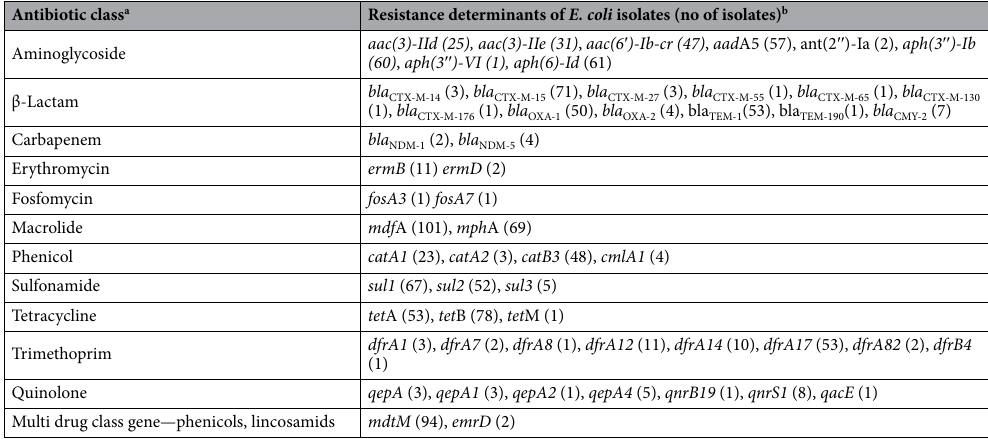
Table 2. Acquired antibiotic resistance genes detected in E. coli isolates recovered from patients attending the National Hospital Abuja, Nigeria expressed in frequencies. a Drugs corresponding to each antibiotic class used in our study are as follows: aminoglycosides, streptomycin, gentamicin; beta-lactams, ampicillin, ceftriaxone, cefotaxime, ceftazidime, ceftiofur, cefoxitin, amoxicillin-clavulanic acid; phenicols, chloramphenicol; folate pathway antagonists, trimethoprim-sulfamethoxazole, sulfisoxazole; tetracycline. b The numbers of isolates carrying each resistance determinant are presented in